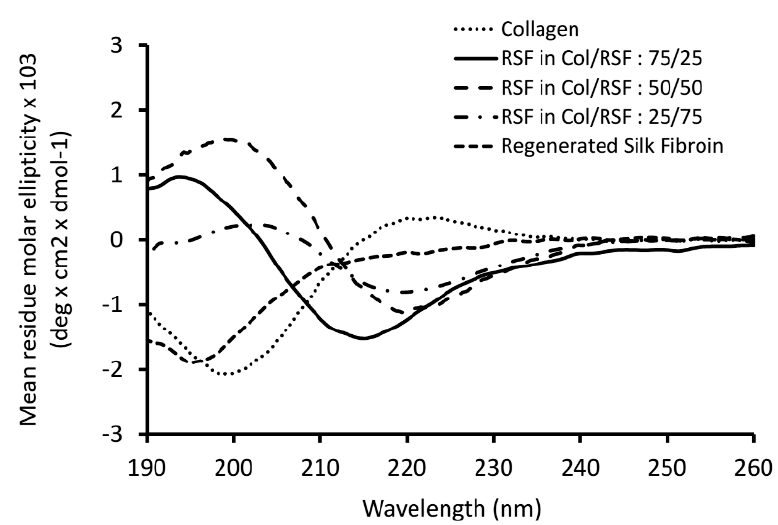
Figure 7. Circular dichroism (CD) spectrum of collagen/RSF mixtures after dialysis.